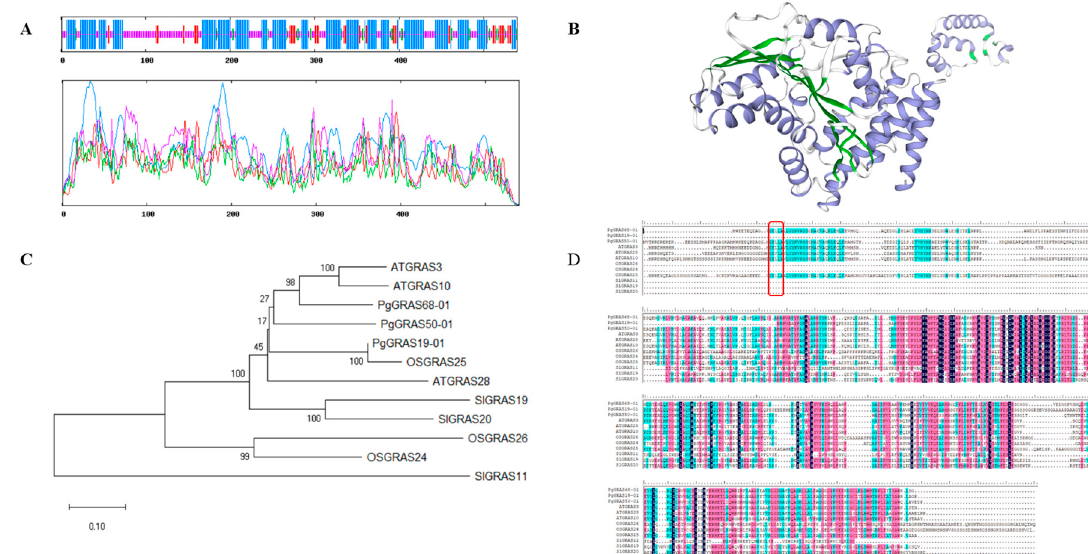
Figure 4. Characterization analysis of the PgGRAS68-01 gene. ( A ) Secondary structure analysis of PgGRAS68-01 protein in ginseng. The blue, green, purple, and red lines represent alpha helix, beta turn, random coil, and extended strand. ( B ) Tertiary structure of PgGRAS68-01 protein. Purple represents the Alpha helix, green represents the Beta turn, gray represents the Random coil. ( C ) Evolu- tionary relationships between PgGRAS68-01 and other members of the GRAS gene family and GRAS genes in other species. ( D ) Amino acid sequence alignment of PgGRAS68-01 to protein sequences of other species. The red box is the DELLA domain.